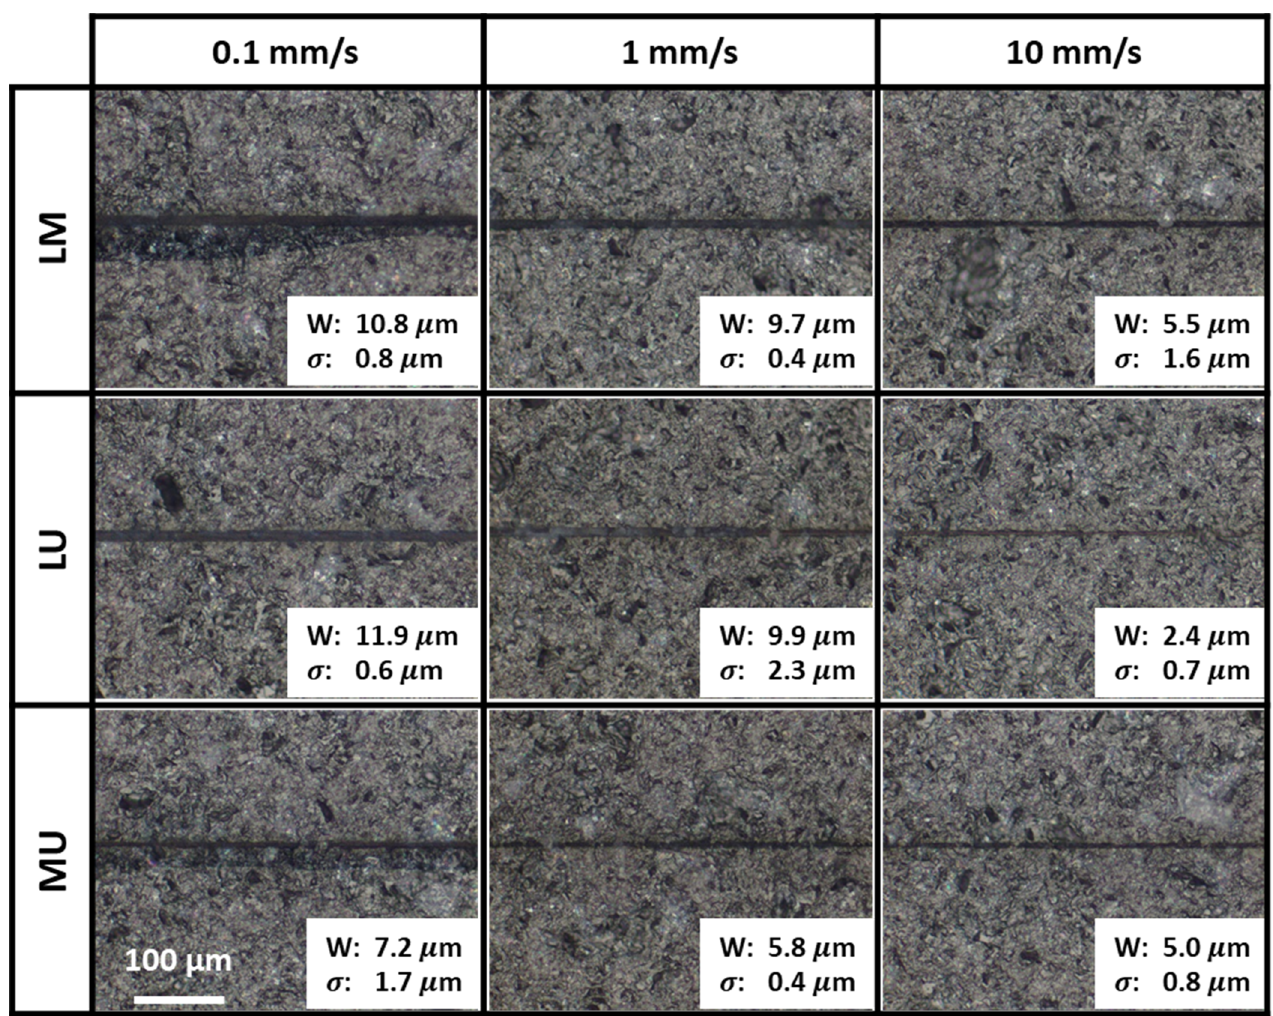
Figure 4. Bottom rough exit surfaces optical images for two-zone scanning showing bottom surface scribes with their widths (W) and standard deviations ( (cid:2026) ) indicated.